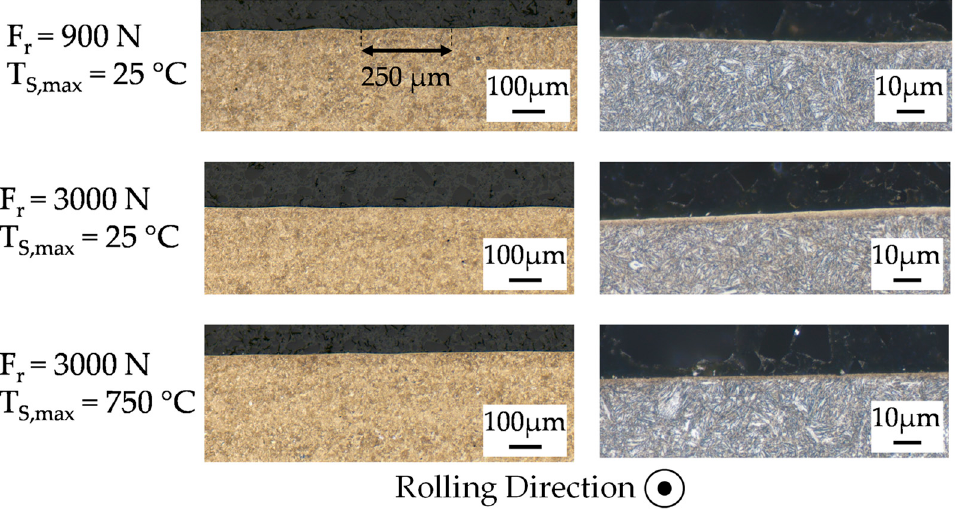
Figure 3. Metallographic cross-sections of the surface layer with different thermomechanical loads. Remaining peaks and valleys from the turning process (f t = 250 µ m) are still visible at F r = 900 N, whereas the deep rolling process at F r = 3000 N has smoothed them out. Considering the larger scale of magnification, a white layer, which has a thickness of a few µ m, is visible in all experiments. Since this layer appears even in tests without laser machining, it can be assumed that the turning operation applied a corresponding thermal load. The effect of further smoothing of the roughness peaks with simultaneous thermal application is not observed. The comparison of the test with the lowest (F r = 900 N; T S,max = 25 ◦ C) and the highest (F r = 3000 N; T S,max = 750 ◦ C) thermomechanical loads